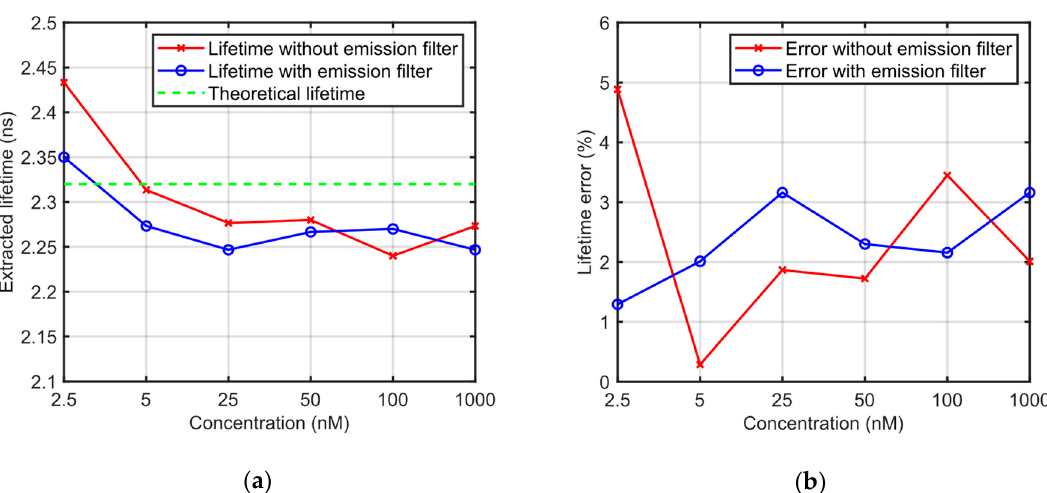
Figure 8. Characterization results of emission filtering performance of LCW. ( a ) Fluorescent lifetime of Coumarin 6 in dimethyl sulfoxide (DMSO) measured by the proposed TCSPC system with and without the emission filter, compared against the theoretical value of 2.32 ns; ( b ) measured lifetime error with and without the emission filter. Lifetime error of the TCSPC system is less than 5%, even without the employment of emission filter, indicating that most of the excitation light is rejected by the